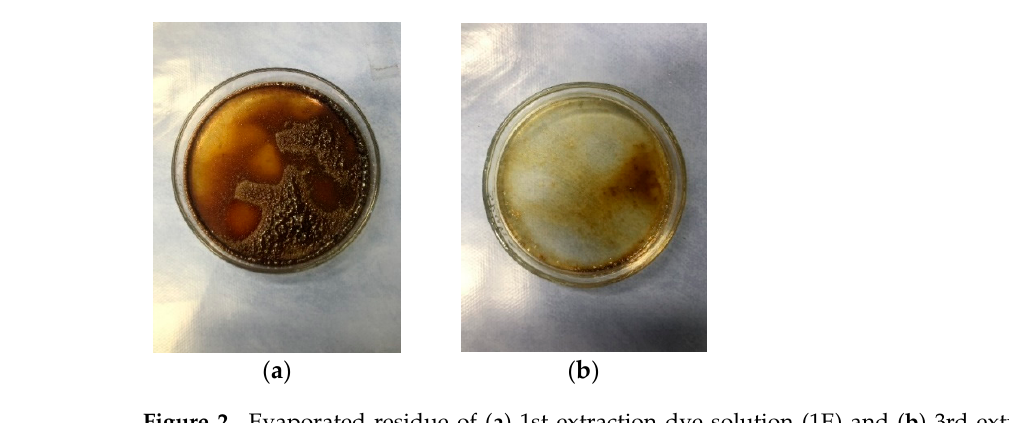
Figure 2. Evaporated residue of ( a ) 1st extraction dye solution (1E) and ( b ) 3rd extraction dye solution (3E). Table 2. Crude dye yield in the investigated dye solutions.